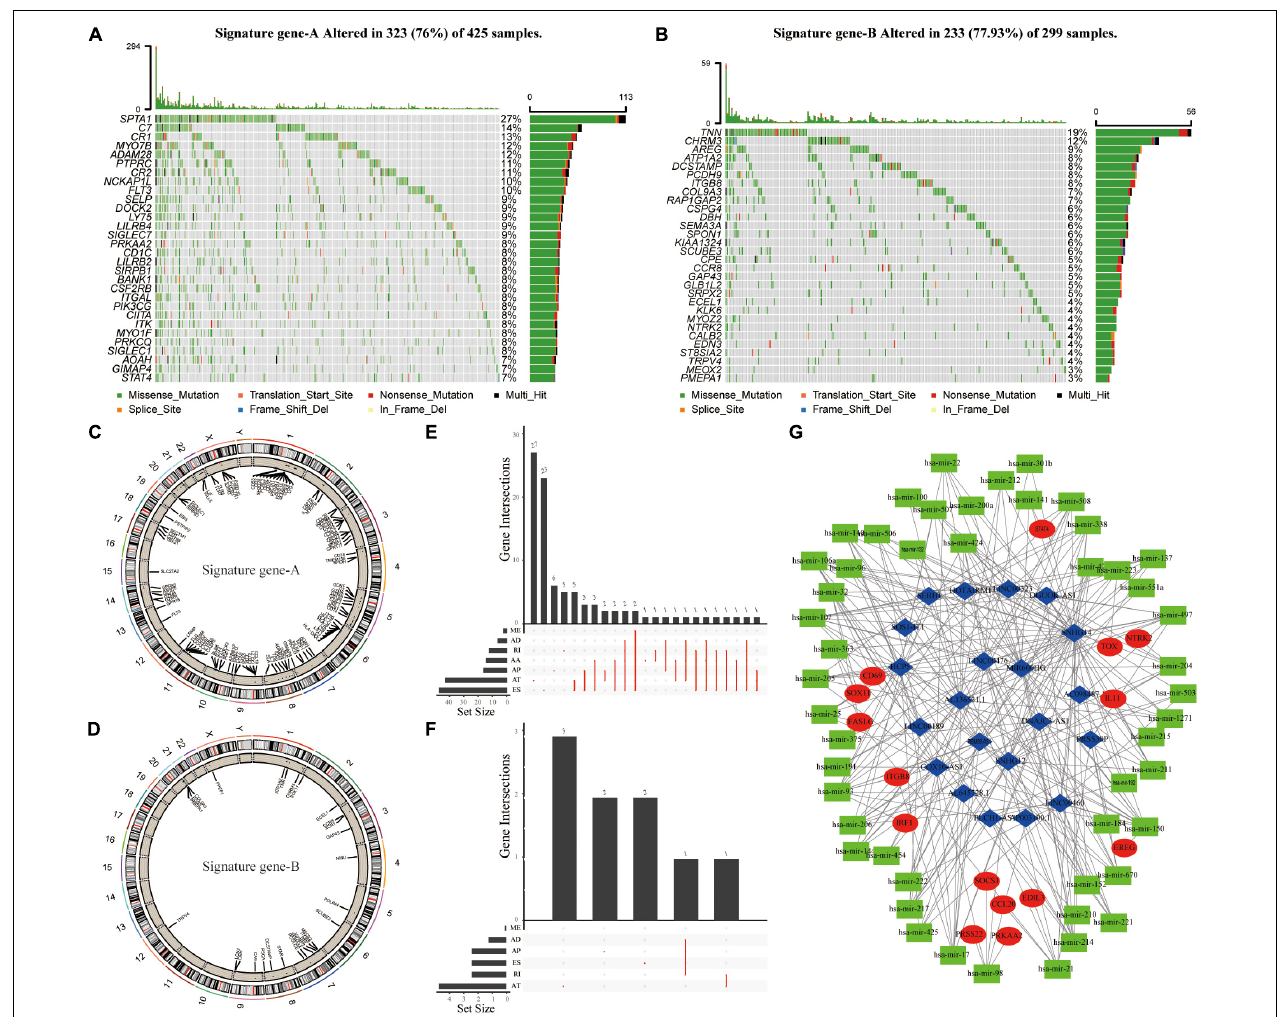
FIGURE 4 | The genetic variation and ceRNA network of Signature gene-A and -B in SKCM patients. (A,B) The mutation maps of Signature gene-A and -B, respectively, in SKCM patients. The mutation information of each gene was displayed in the waterfall chart, and various colors indicated different mutation types; the upper section of the legend showed the mutation load. (C,D) Signature gene-A and -B are, respectively, on 23 chromosomes of SKCM patients. The CNV difference and its position on the above. (E,F) UpSet diagram showing the variable splicing of Signature gene-A and -B in SKCM patients. (G) Based on the expression